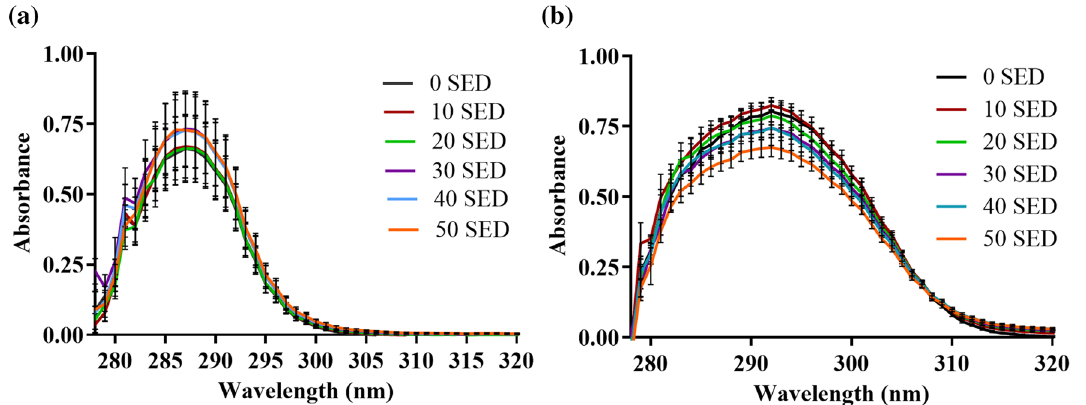
Figure 2. Photostability of α-TP ( a ) and α-T ( b ) when exposed to SSR. Antioxidants (1 mM) were exposed to increasing doses of SSR (10–50 SED) (n = 3). α-TP and α-T displayed very little evidence of photodegradation. Data represent mean ± SD (n =